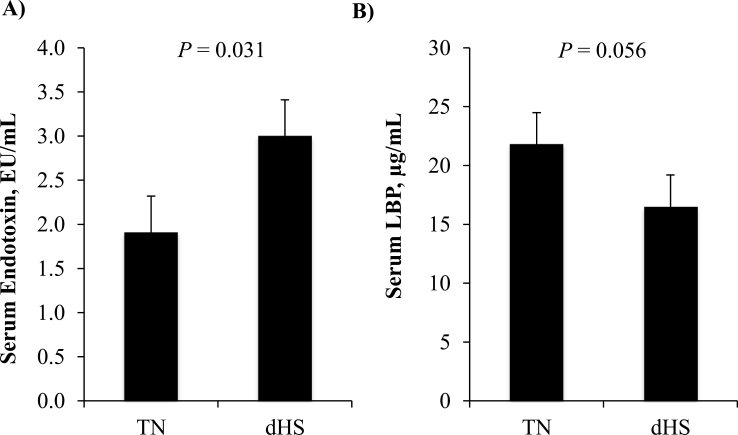
The effect of dHS or TN conditions on circulating serum (A) endotoxin and (B) LPS-binding protein (LBP) concentrations. Blood samples were collected from pigs after they were dHS (6 h at 38°C, 40–60% humidity followed by 18 h at 32°C, 40–60% humidity) for 3 d or reared under constant TN (28°C; 40–60% humidity). n = 24 pigs per treatment.